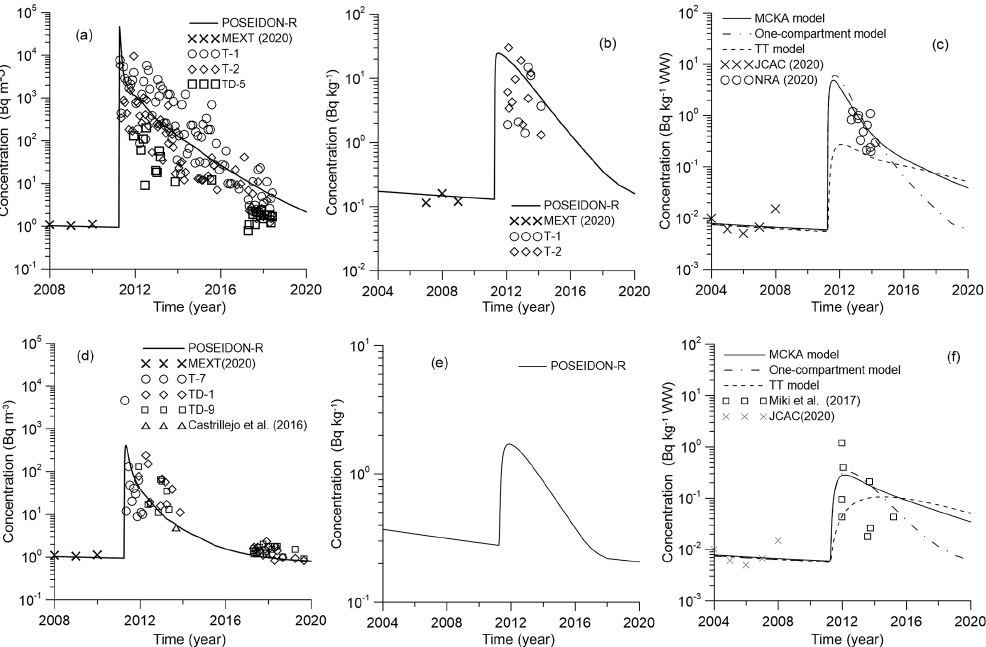
Figure 10. Comparison between calculated and measured 90 Sr concentrations in water (a) , bottom sediment (b) and piscivorous fish (c) for the coastal box and in water (d), bottom sediment (e) and piscivorous fish (f) for box no. 173.